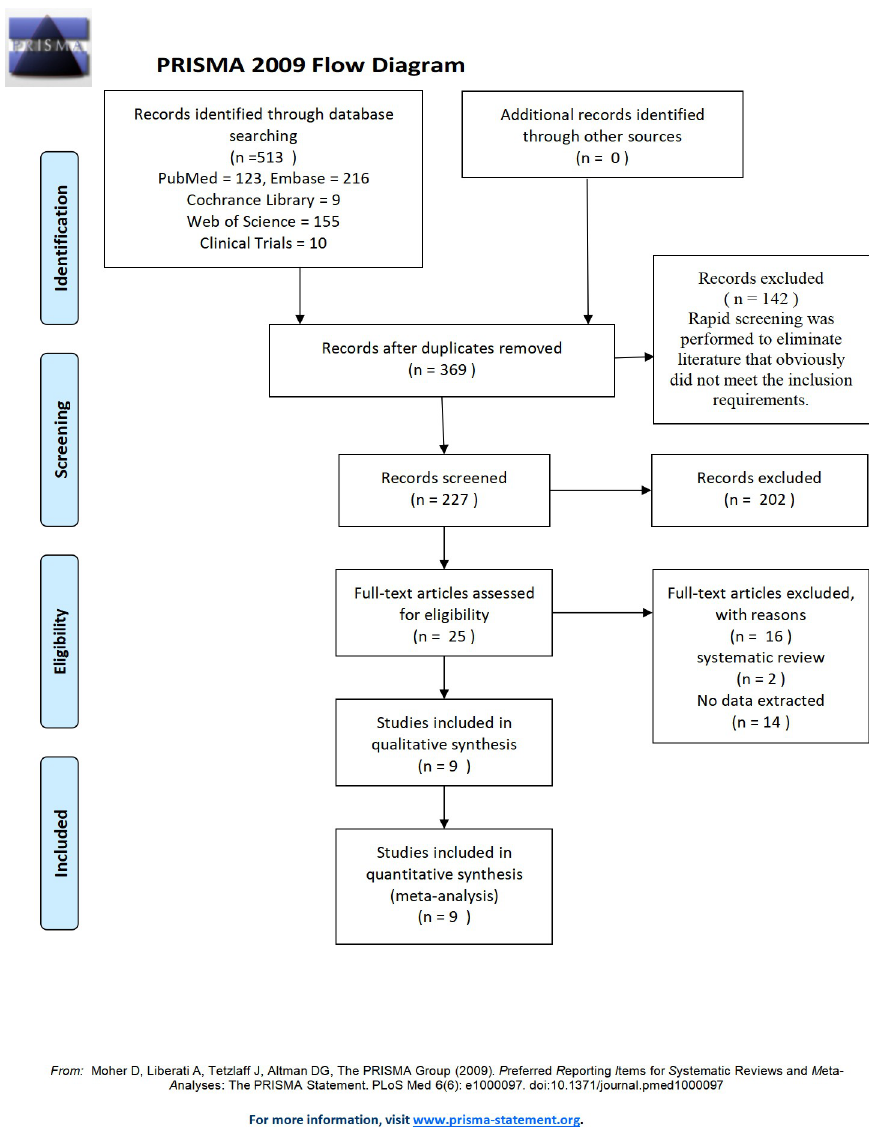
Fig 2. PRISMA flow diagram of evidence acquisition during the